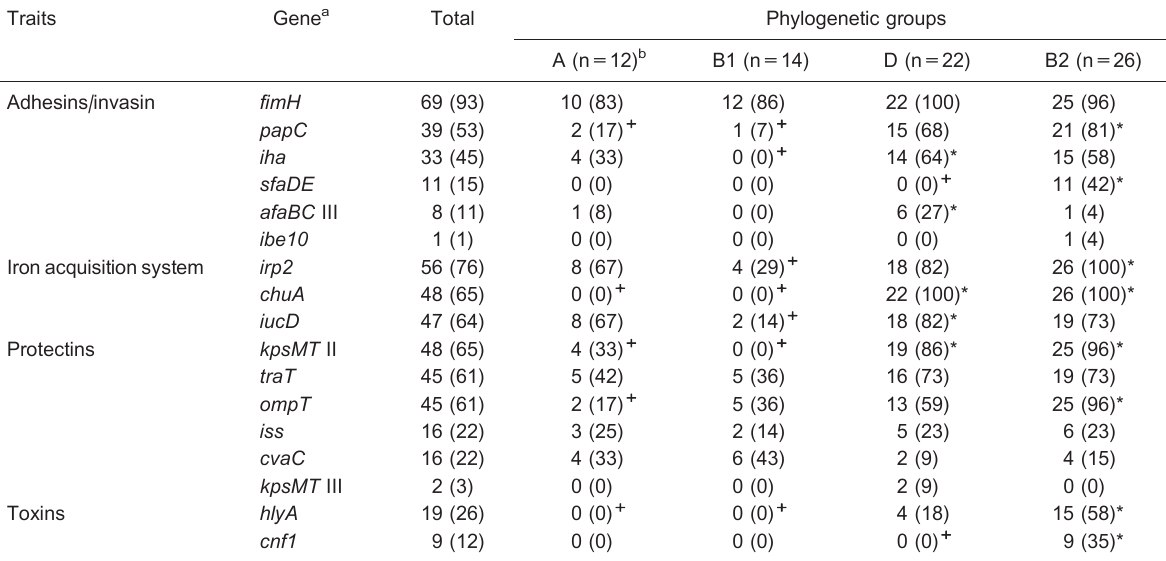
Table 1. Frequency of virulence factors and their distribution among phylogenetic